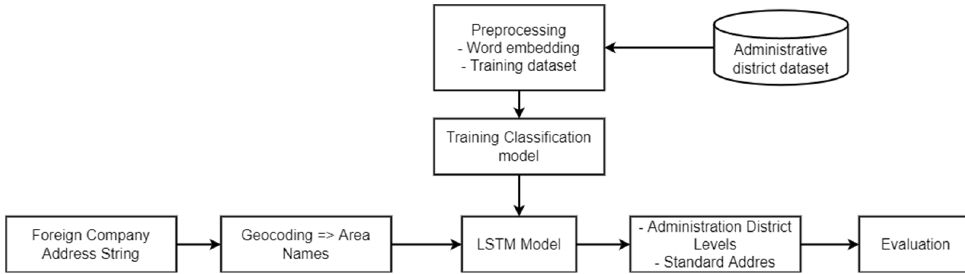
Figure 3. Proposed methodology flow.